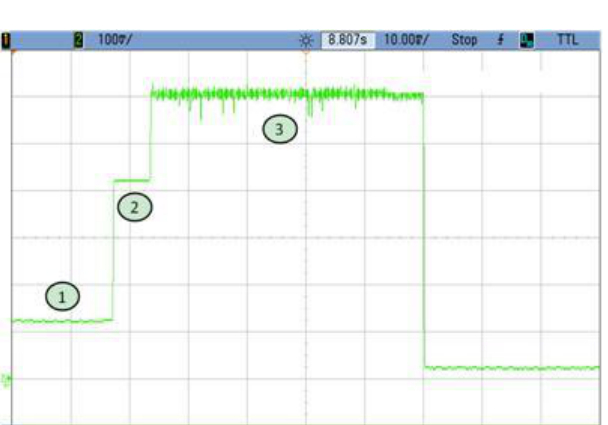
Figure 16. Test 6 SHA1